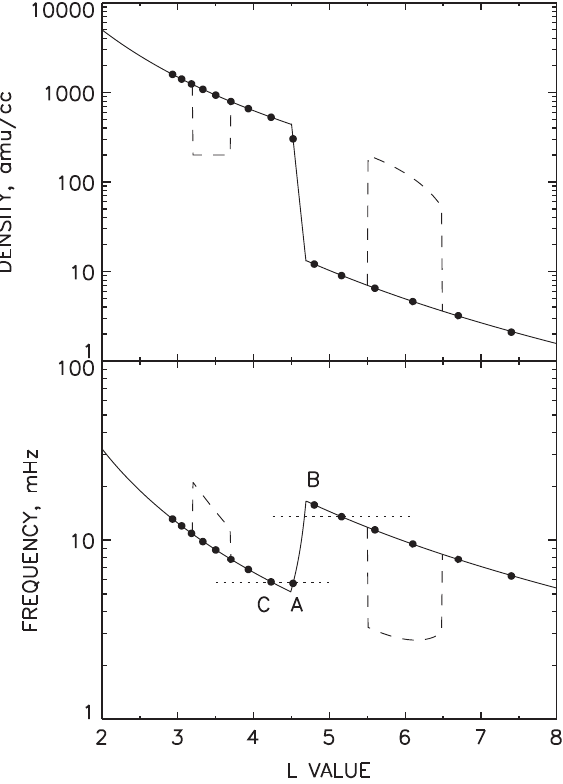
Fig. 1. Model equatorial mass density profile (top) and corresponding radial variation in toroidal mode resonance frequency (bottom). Filled circles represent projection of ground stations separated by 110 km in geographic latitude, with A, B and C straddling the plasmapause (see text).Dashedlinesdepictaplasmasphericdensitytroughorbiteoutanda hypothesized plasma drainage